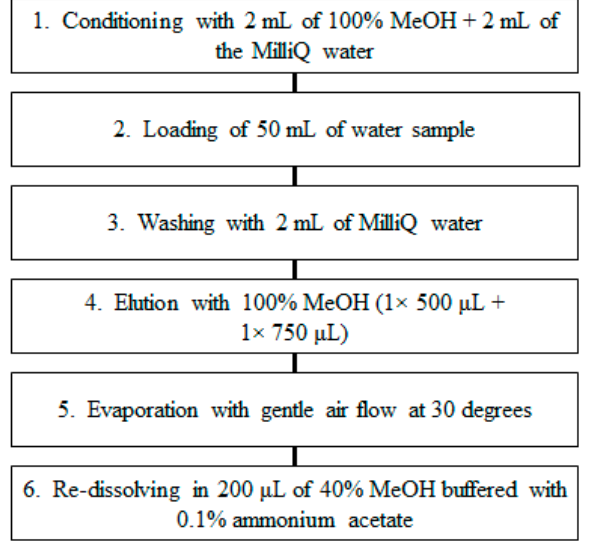
Figure 2. Solid-phase extraction (SPE) flow chart.